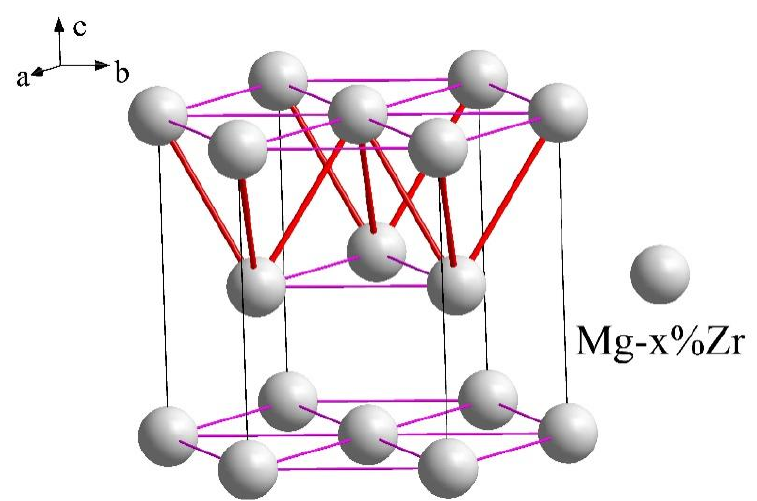
Figure 6. Primary bond distribution in the cell of Mg– x %Zr crystal structure; primary keys are marked with thick red lines.